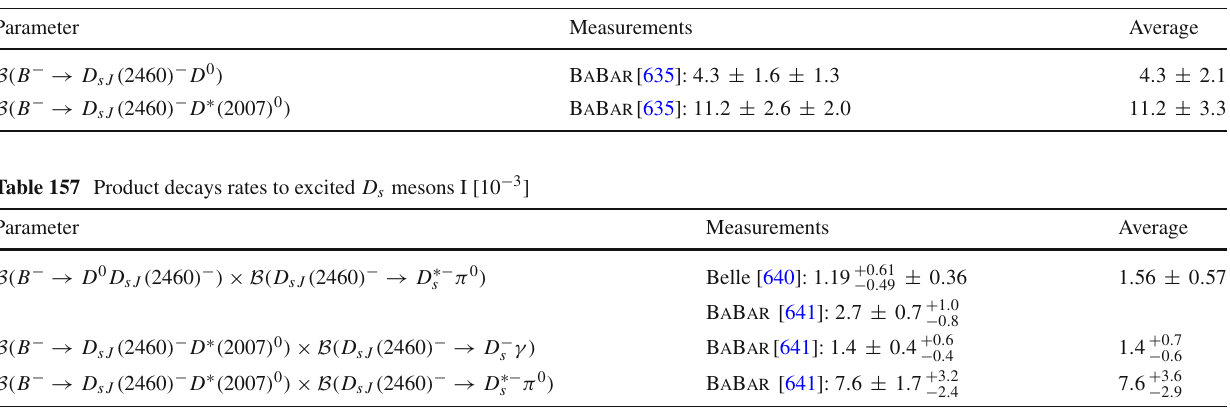
Table 158 Product decays rates to excited D s mesons II [ 10 − 3 ] Parameter